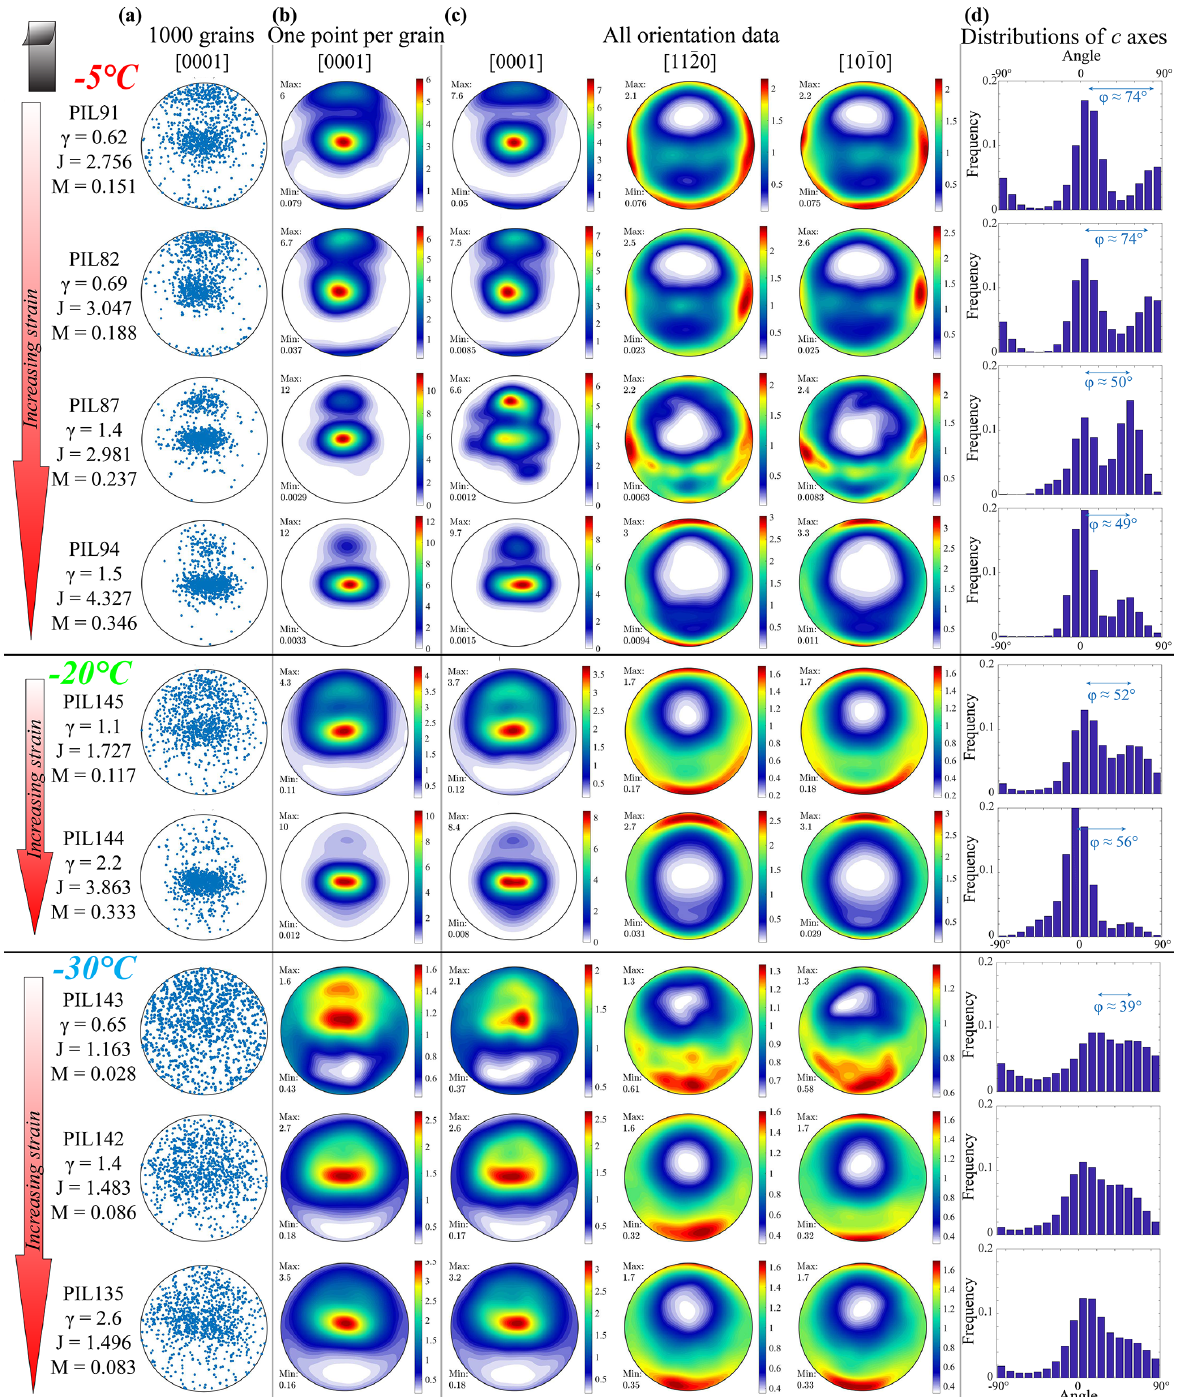
Figure 4. Analysis of crystallographic orientations on the shear plane of all deformed samples. Samples are grouped by their experimental temperatures, with groups are separated by black horizontal lines. All data are from the shear plane. The shear direction is top side up, as illustrated by the bold black arrow. Step size is between 30 and 50µm (see Table 2, columns 2–4). J and M indexes are calculated based on all orientation data. (a) Distributions of orientations of [0001] axes from 1000 randomly selected grains. (b) Distributions of orientations of [0001] axes contoured on the basis of one point per grain. (c) Distributions of orientations of [0001], [1120] and [1010] contoured on the basis of all orientation data. The contours on each stereonet are colored by multiples of a uniform distribution (MUDs), values of which are indicated in the color bar next to the stereonet. (d) Distributions of the [0001] axes on the great circle normal to the shear surface. The angle between the two clusters, ϕ , is presented on each